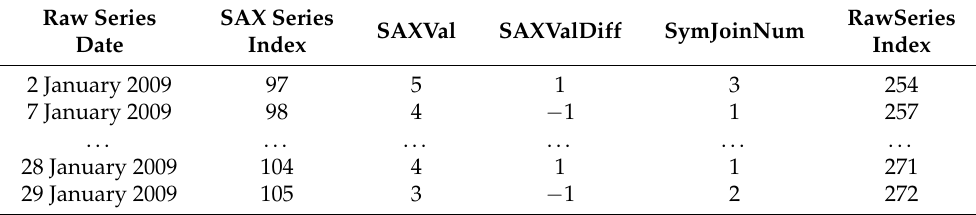
Table 1. Sample additional detail recorded during the construction of an MDL-SAX string. SAXVal is the value of the SAX series at a given index, SAXValDiff is the difference between the current and previously recorded SAX value, while SymJoinNum is the number of consecutive SAX series values combined through the application of MDL .